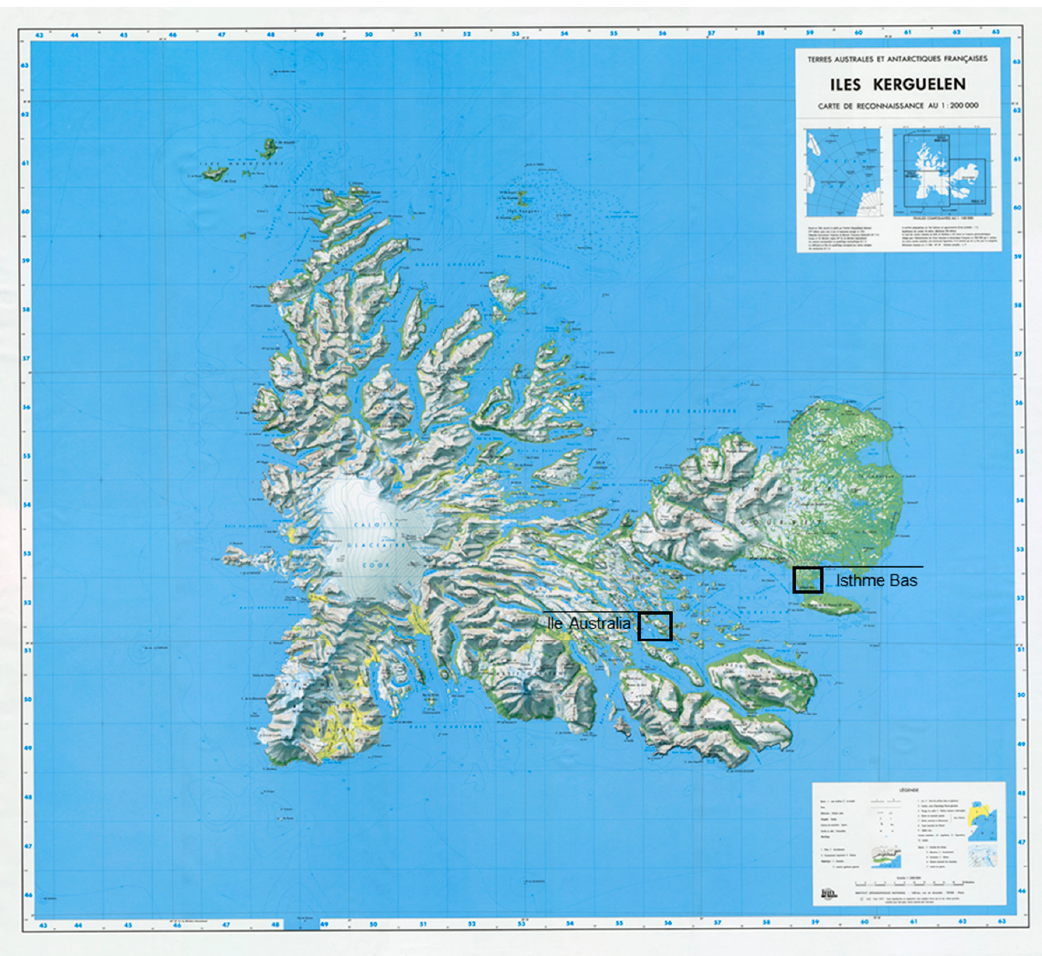
Figure 5. Sampled regions in Iles Kerguelen (modified from IGN [Institut Géographique National, France] map).